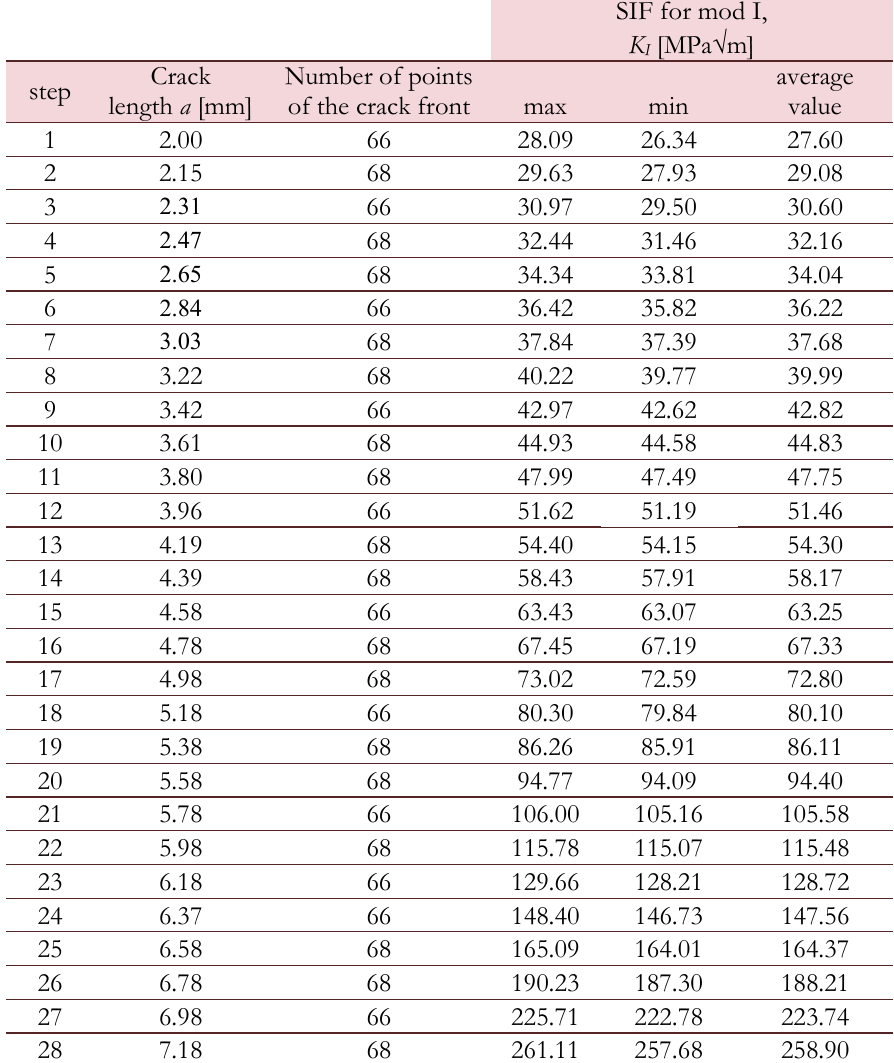
Table 3: Values for K I for all steps (28)